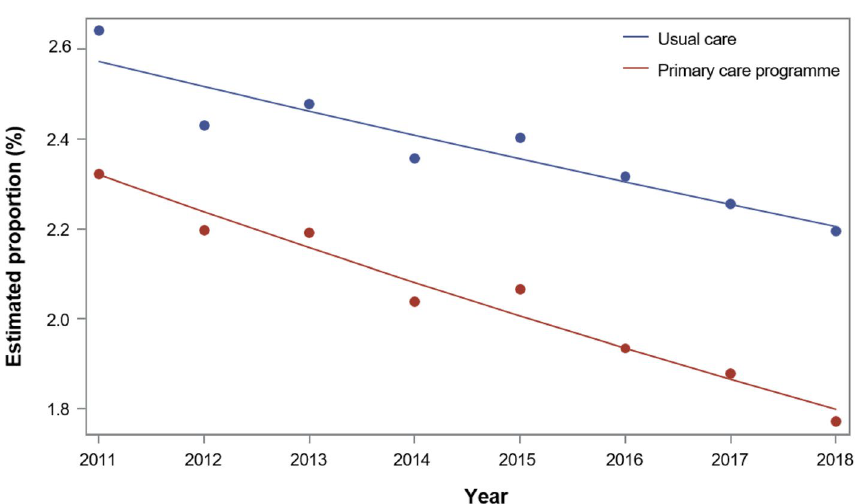
Figure 1. Estimated proportions of all-cause hospitalization in the elderly, based on generalized linear models of the 2011–2018 longitudinal